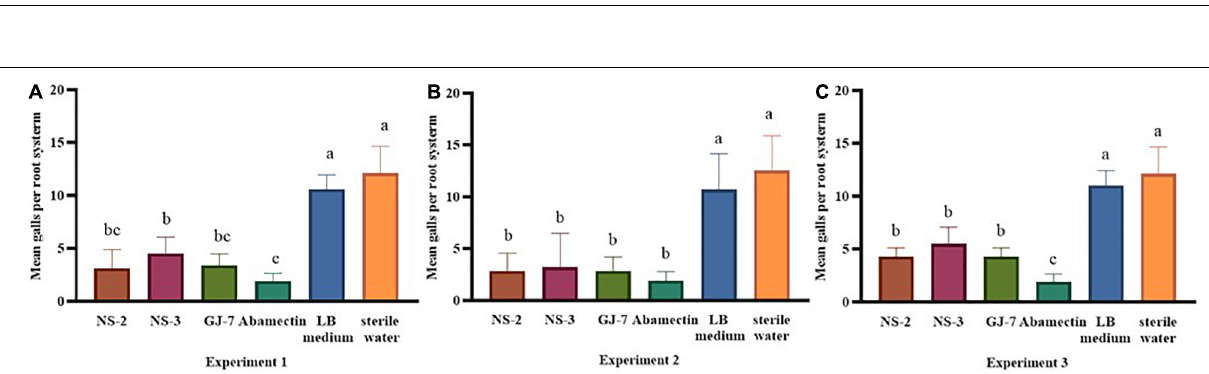
FIGURE 2 | The egg hatching rate of Meloidogyne hapla exposed to Bacillus cereus strain NS-2, Lysinibacillus strain NS-3, and Bacillus velezensis GJ-7 cell-free supernatant in vitro . LB medium, 10% LB medium, and sterilized water were used as negative controls. Data were analyzed by one-way ANOVA with Duncan’s multiple range test, and error bars represent standard error of three biological and ten technical replicates ( n = 30). Different lowercase letters indicate significant differences of 72 h among treatments ( P < 0.05).